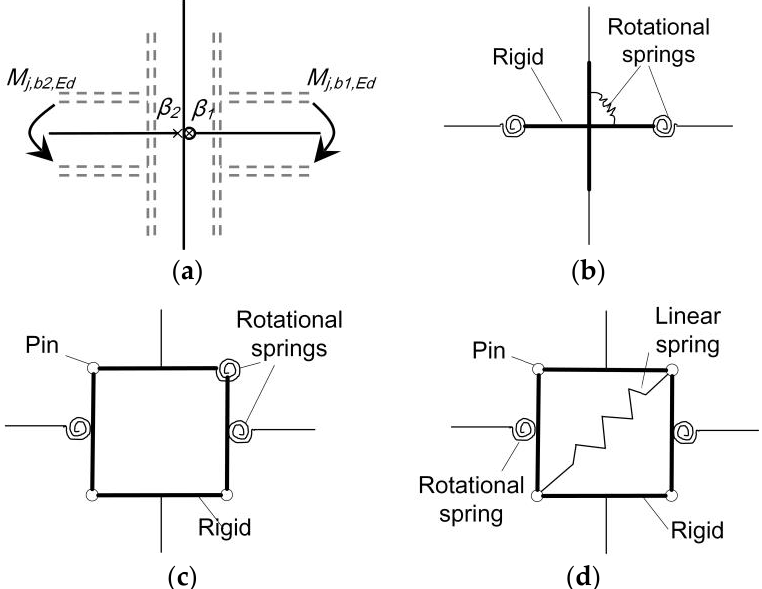
Figure 14. Joint modelling: ( a ) Two separate springs; ( b ) Scissor links; ( c ) Rotational spring box; ( d )